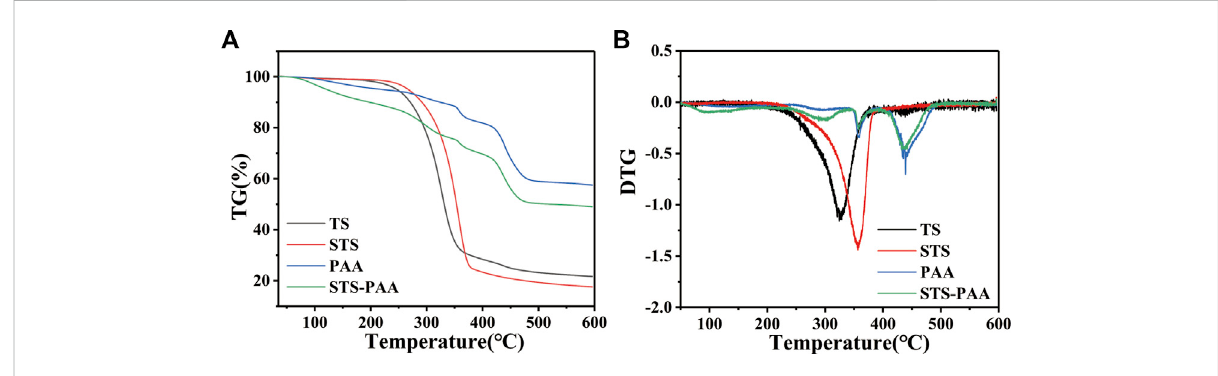
FIGURE 6 (A) TG and (B) DTG curves of TS, STS, PAA and